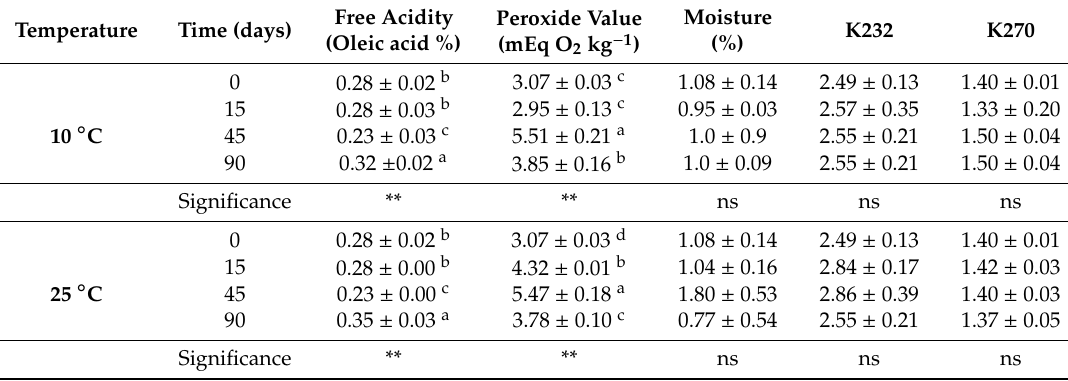
Table 3. Qualitative parameters of Mboil during storage at 10 and 25 ◦